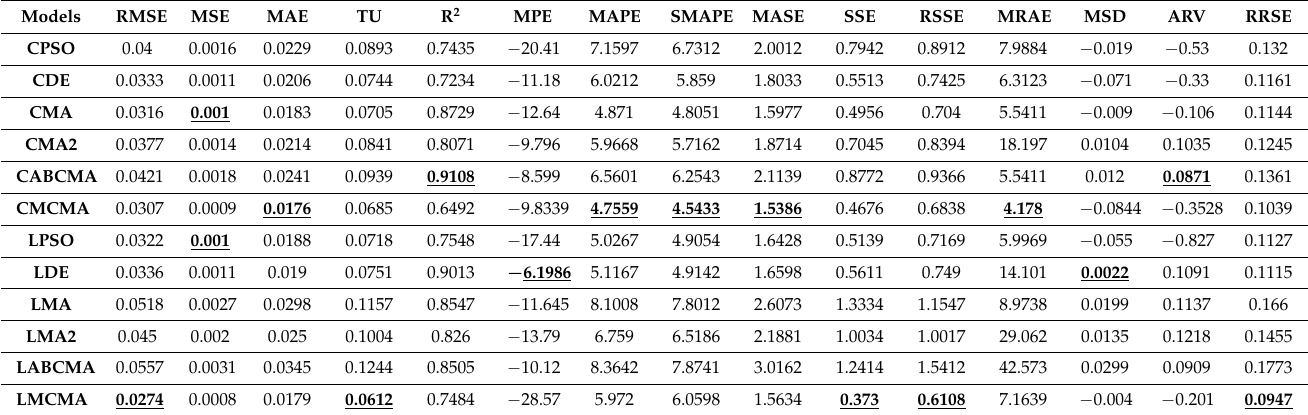
Table 5. Performance Metrics for BTC/JPY